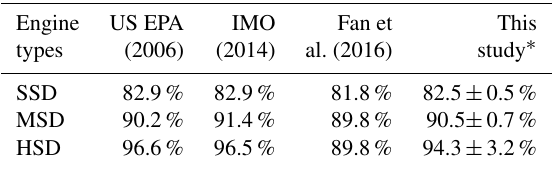
∗ Calculated based on the average values reported in previous